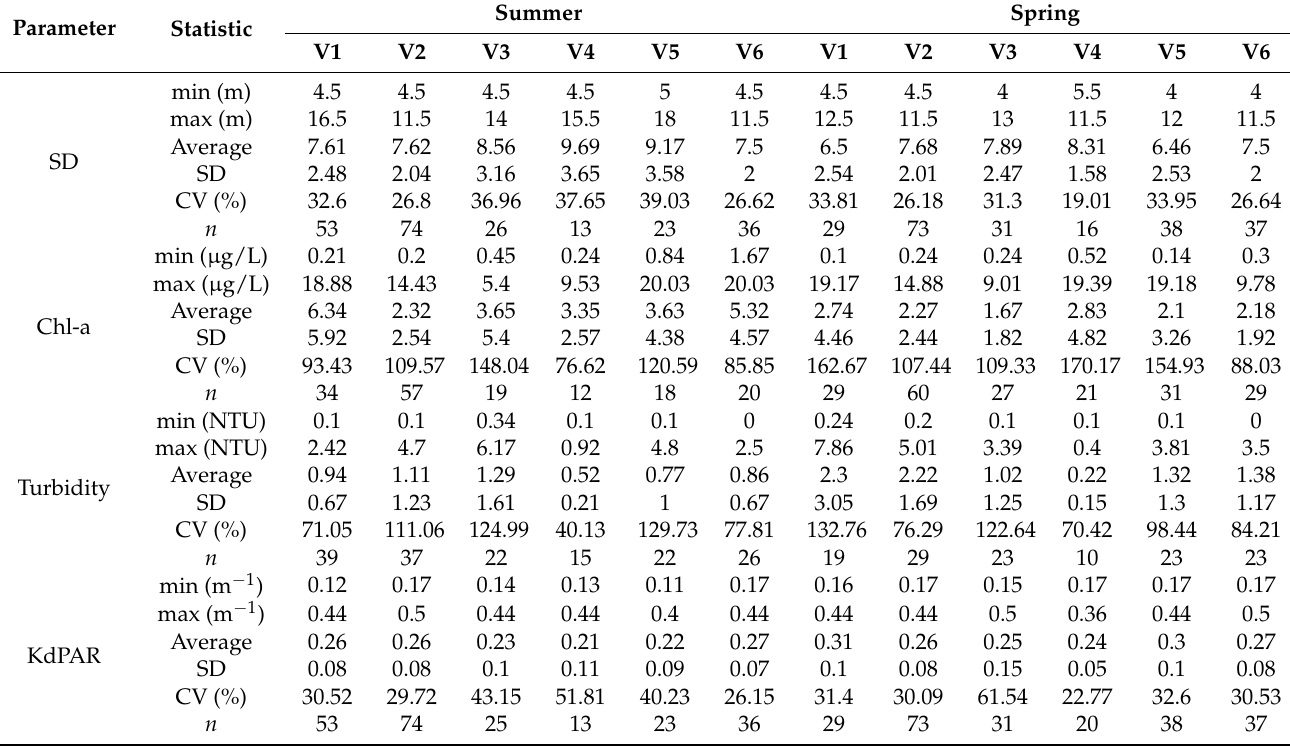
Table 2. Descriptive statistics of water quality parameters for Lake Villarrica during summer and